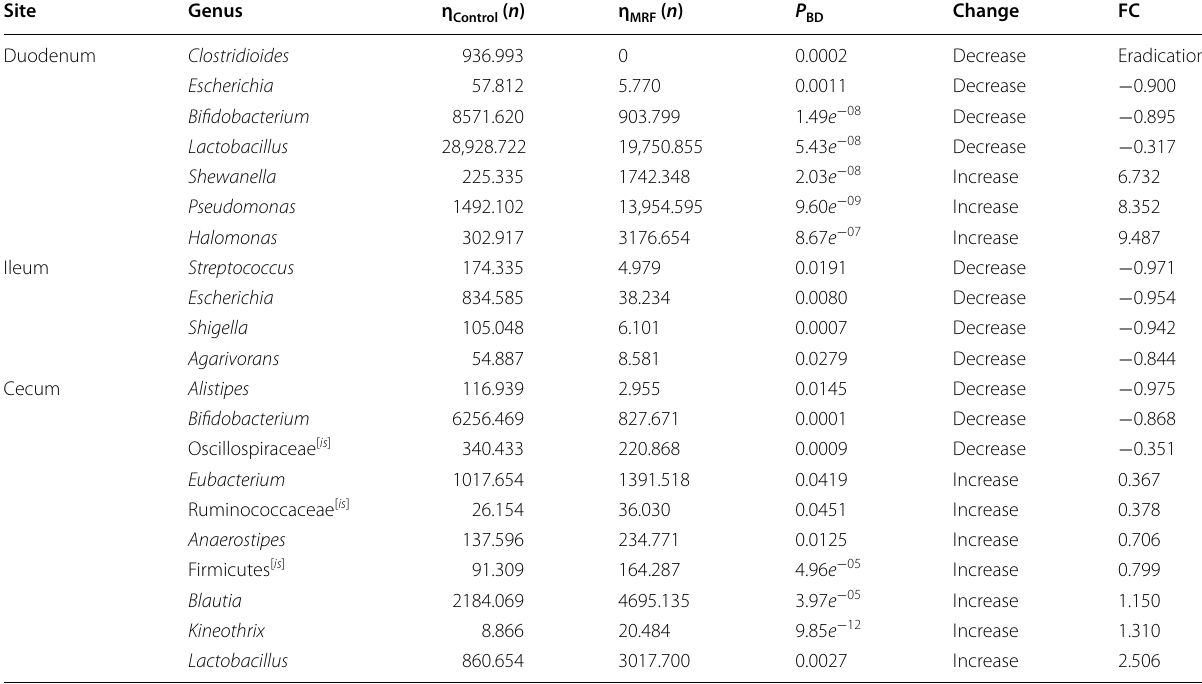
Standardised median read counts ( n ) are presented to illustrate the magnitude of the fold change. [ is ] represents incertae sedis